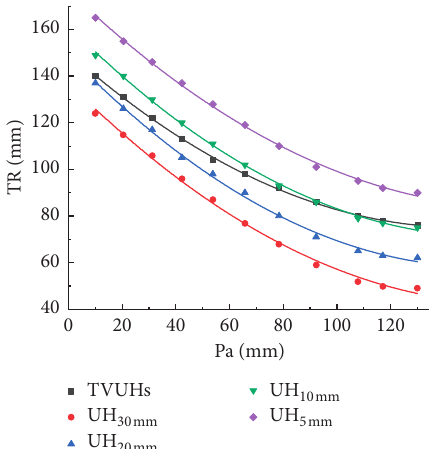
Figure 7: TR-Pa curves of different